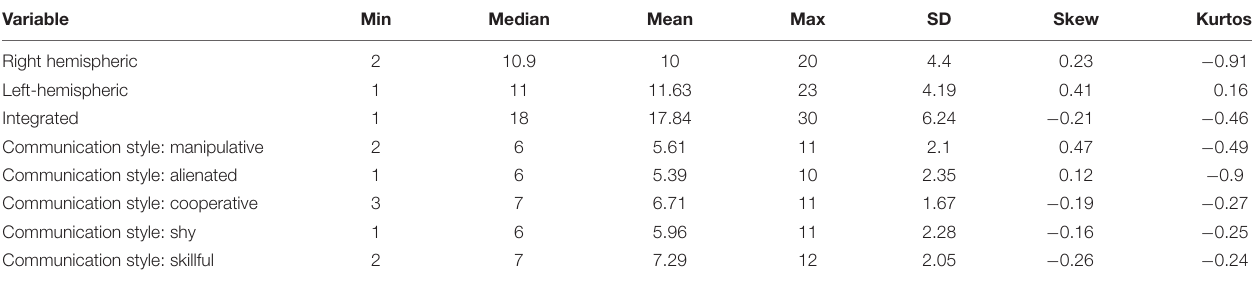
TABLE 1 | Descriptive